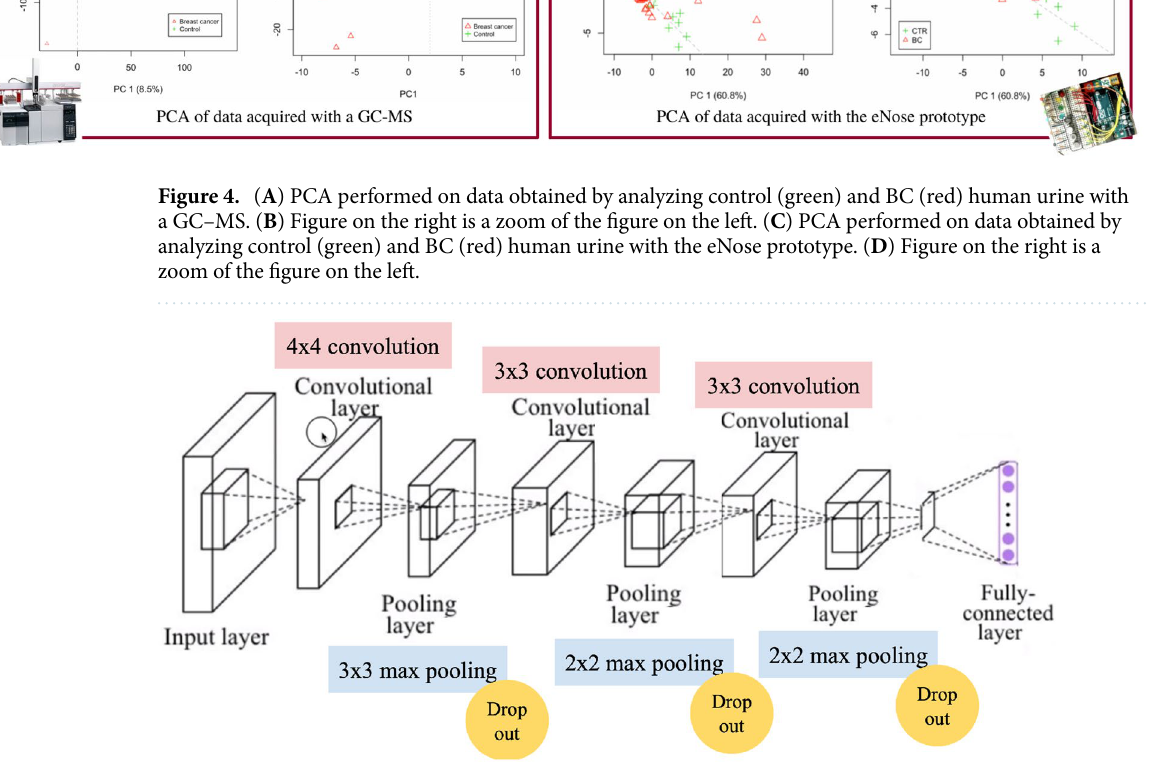
Figure 5. Convolutional neural network used for sample classification, consisting of convolutional filters of size 32, 64, 128 and linear activation. The output layer of the neural network presents two cells (two outputs) with a softmax activation